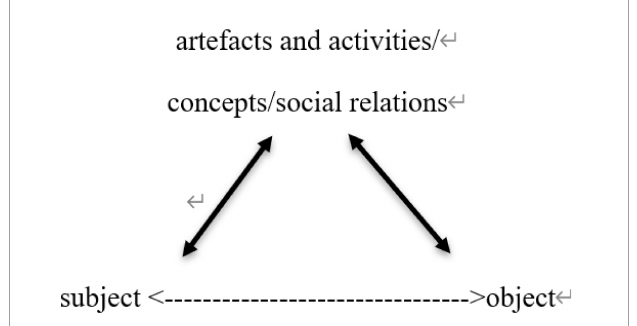
FIGURE1 The mediate nature of human/world relationship (adapted from Lantolf and Thorne,